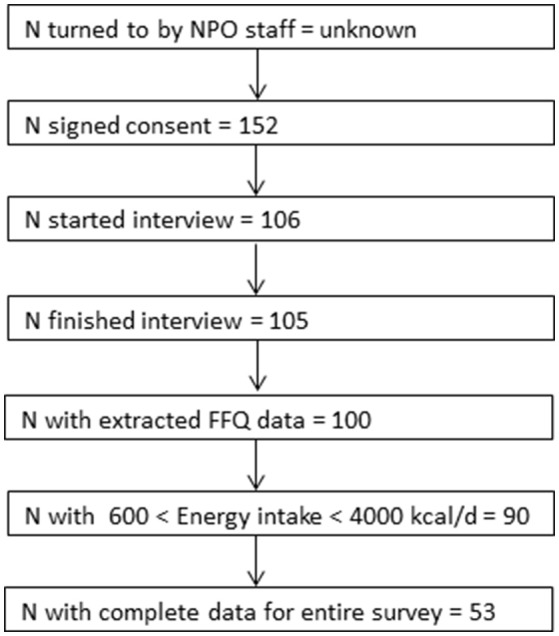
Study population flow chart.